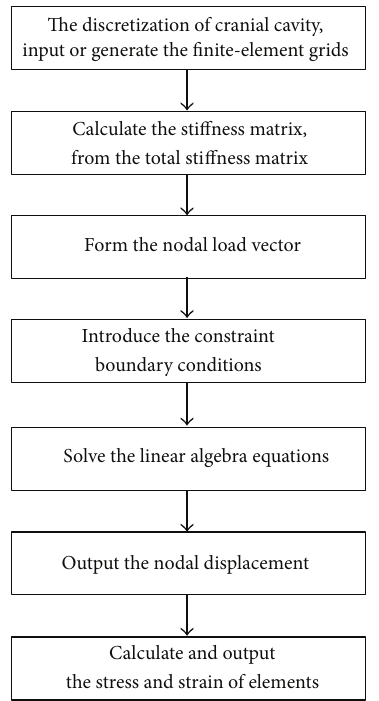
Figure 1: Block diagram of numerical solution steps of cranial cavity with the finite element